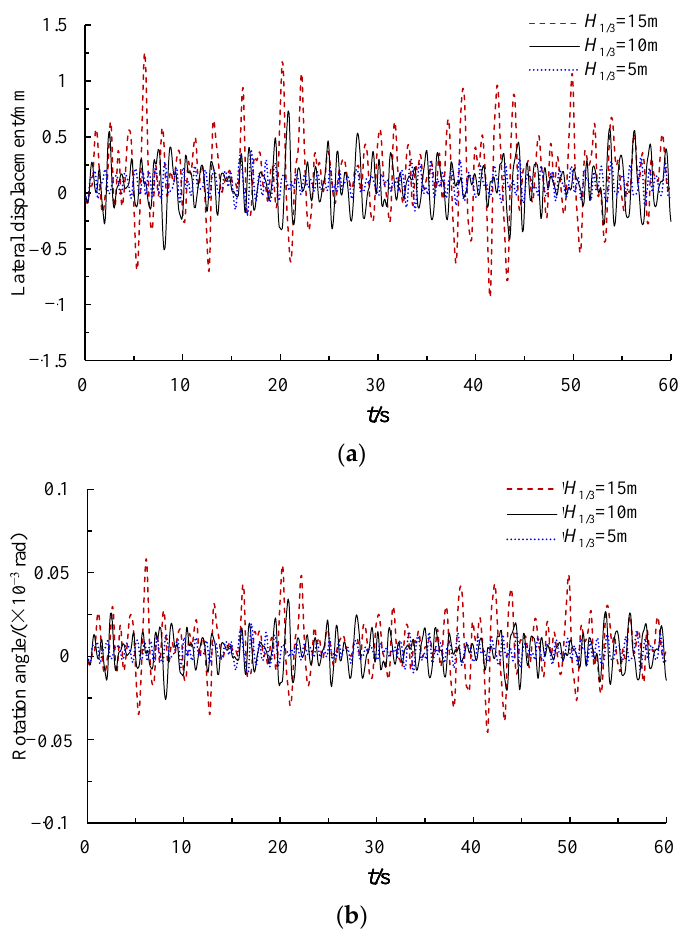
Figure 18. Dynamic response of the GBF under different wave loads: ( a ) lateral displacement, ( b ) rotation angle.